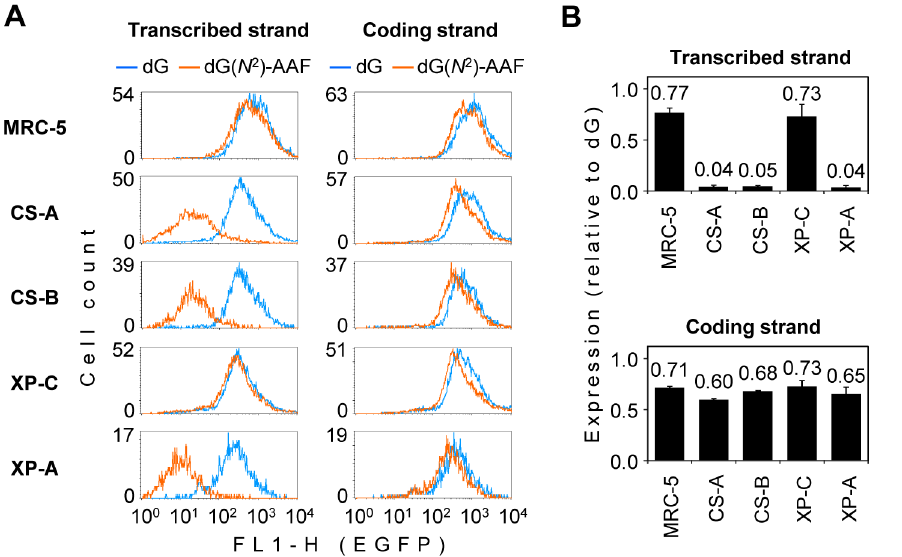
Figure 3. Exclusive requirement of TC-NER for the removal of transcription-blocking dG( N 2 )-AAF. Host cell reactivation in human cell lines of the specified nucleotide excision repair complementation groups (CS-A, CS-B, XP-C and XP-A) and in the repair proficient cell line (MRC-5). The expression constructs contained a unique dG( N 2 )-AAF or dG in the specified DNA strand. (A) Overlaid fluorescence distribution plots obtained in a representative experiment. All cell lines were transfected in parallel with the same constructs. (B) Mean relative expression (dG( N 2 )-AAF/dG) calculated for multiple transfections with independent preparations of the expression constructs (n=3, + / 2 s.d.).